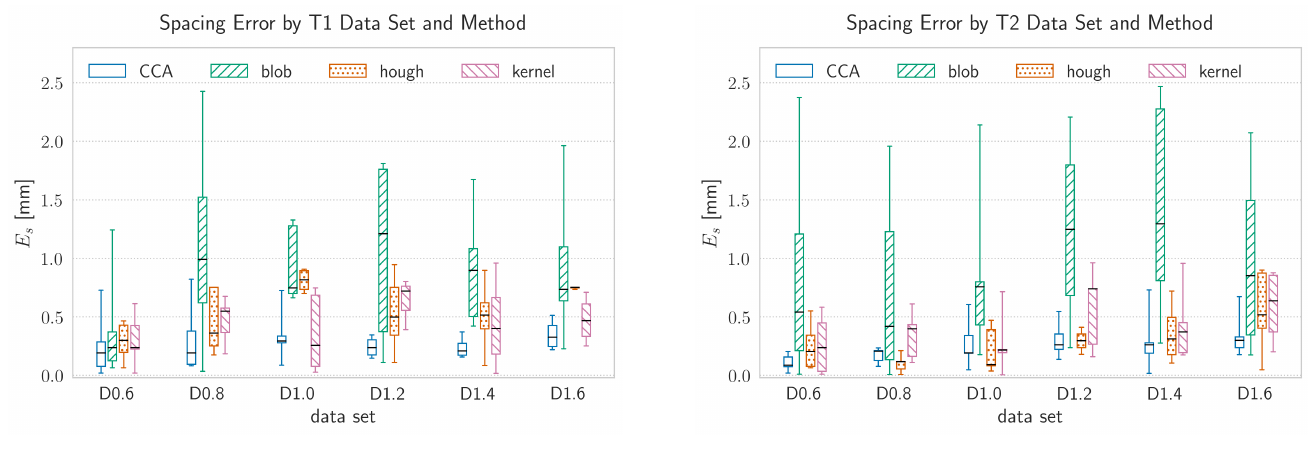
Figure 9. The spacing error, E s , by data-set and method. E s reflects the deviation of the relative distance between two marker spheres of the same marker and the constructive-wise fixed distance value of 11mm. Since this error is evaluated upon marker model assumptions, it serves as a ground-truth bias independent measure for the spatial error. The mean spacing error of the manual ground-truth measurements across all data-sets was 0.22mm with a standard deviation of 0.17mm. Each data-set was acquired at a different voxel size, ranging between s =[ 0.6, . . . ,1.6 ] mm in ∆ s = 2mm steps. The data-sets are ordered by increasing voxel size from left to right, where the data-set name annotates the voxel size in the following manner: D x.x , with x.x denoting the voxel size in